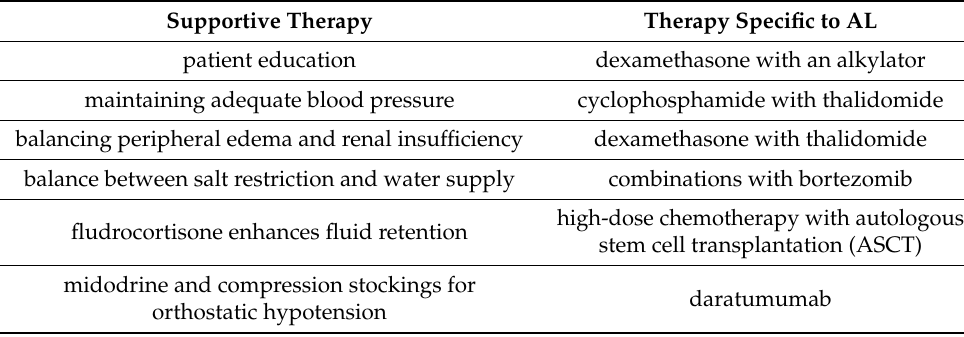
Table 4. Therapeutic opportunities in AL